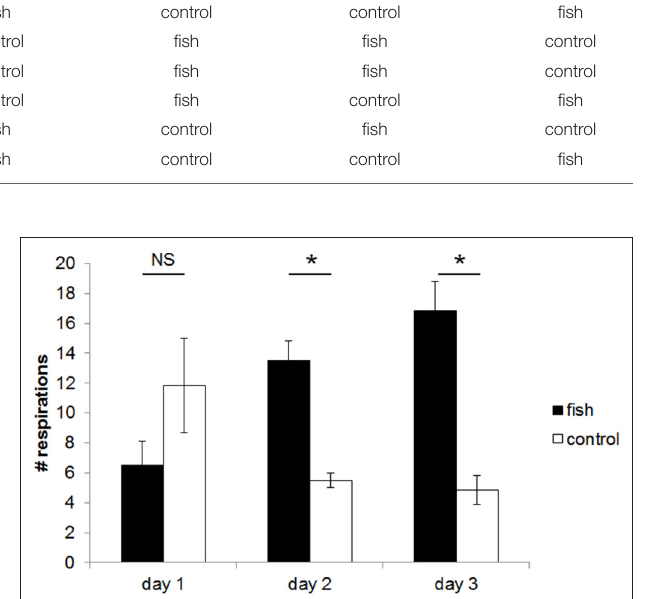
FIGURE 2 | Mean ( ± SE) number of respirations per 10min of the dolphins in the area within a radius of 2.5m around the barrel containing fish or the empty control barrel. The dolphins breathed more often close to the barrel containing fish compared to the control barrel both at day 2 and 3. Statistical difference is indicated by asterisks ( * P ≤ 0.05; NS, not significant; two-tailed Wilcoxon signed rank tests using the sums of each individual’s values obtained during the sessions of the 3 days of the three experimental